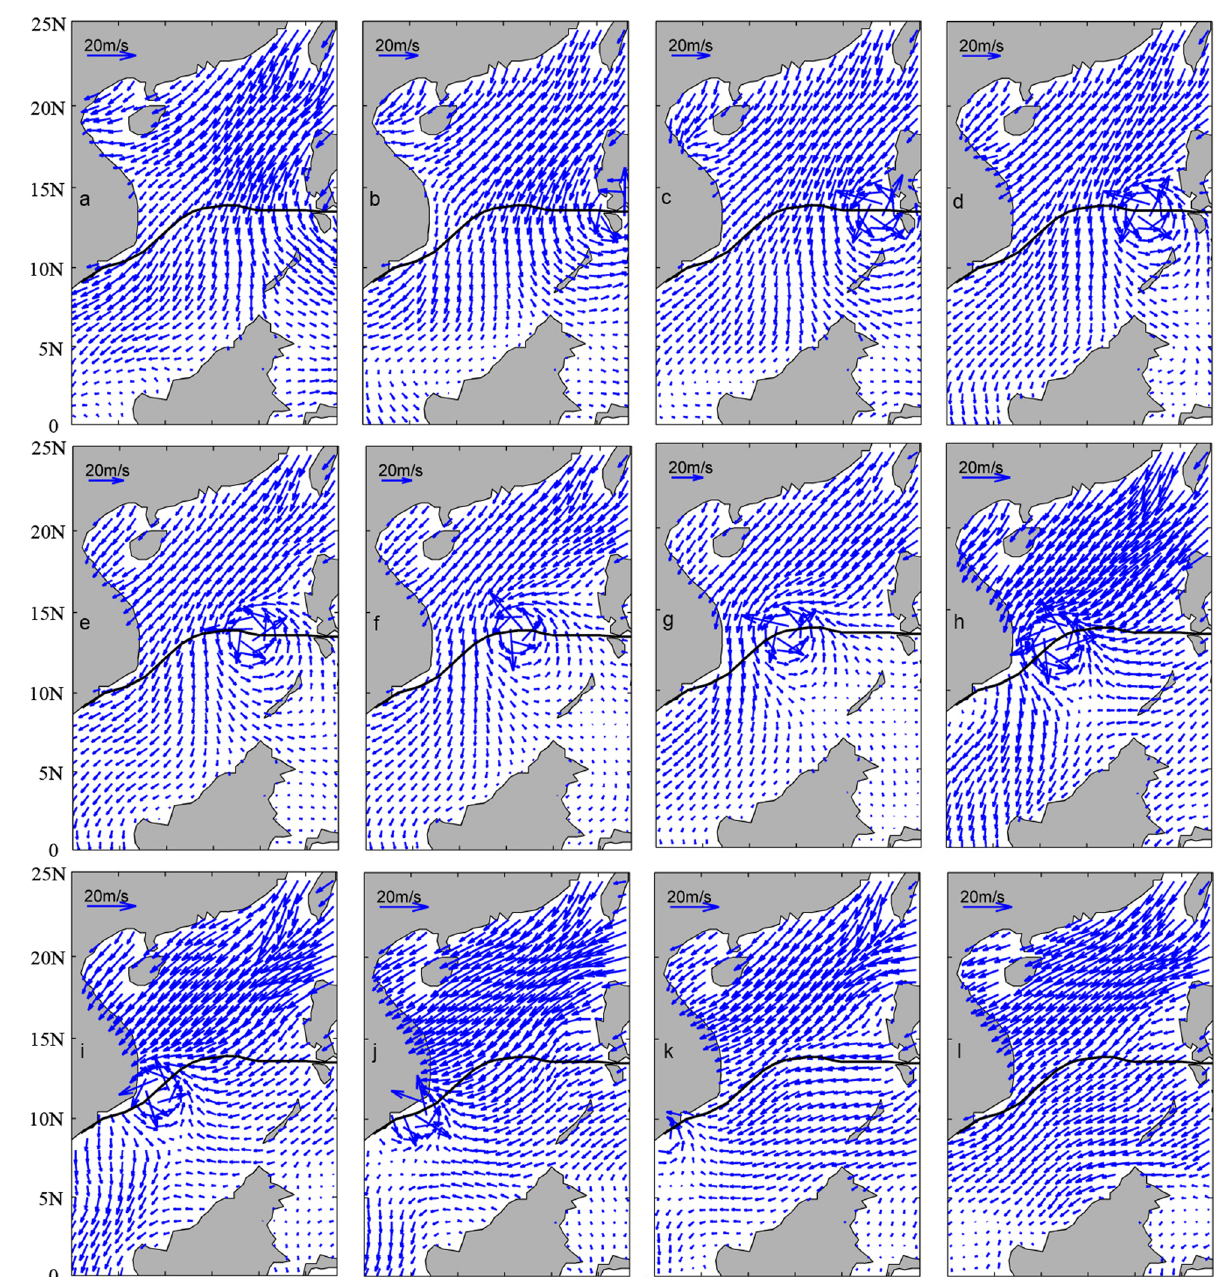
Figure 3. Twelve-hour evolution of the blended wind vector fields from 0600UTC November 30 to 1800UTC December